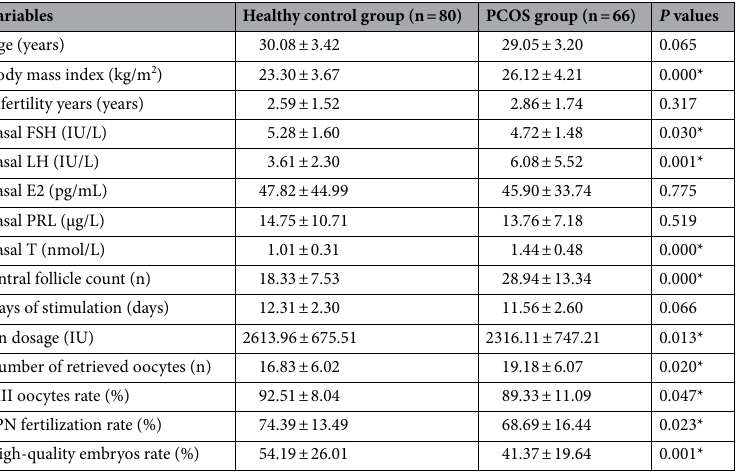
Table 1. Comparison of clinical characteristics between healthy control group and PCOS group. The data are presented as the mean ± SD. FSH follicle-stimulating hormone, E2 estradiol, LH luteinizing hormone,